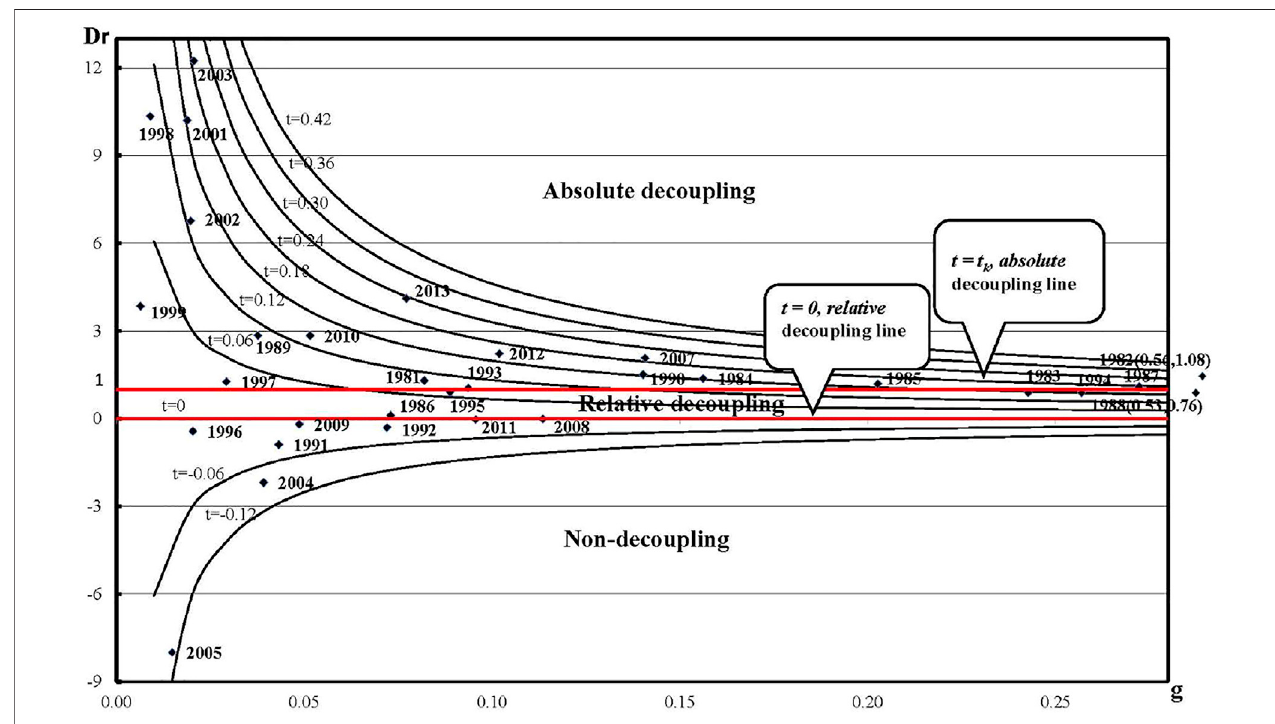
FIGURE 4 | The degrees of coupling and decoupling of WF growth from agricultural GDP growth (based on the IPAT equation).